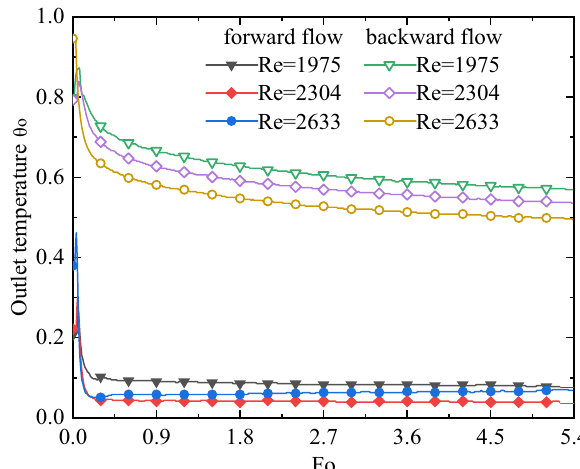
Fig. 10 The variation of outlet temperature with time in both flow